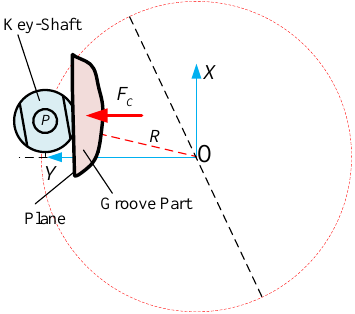
Figure 8. The motion diagram of key-slot component.